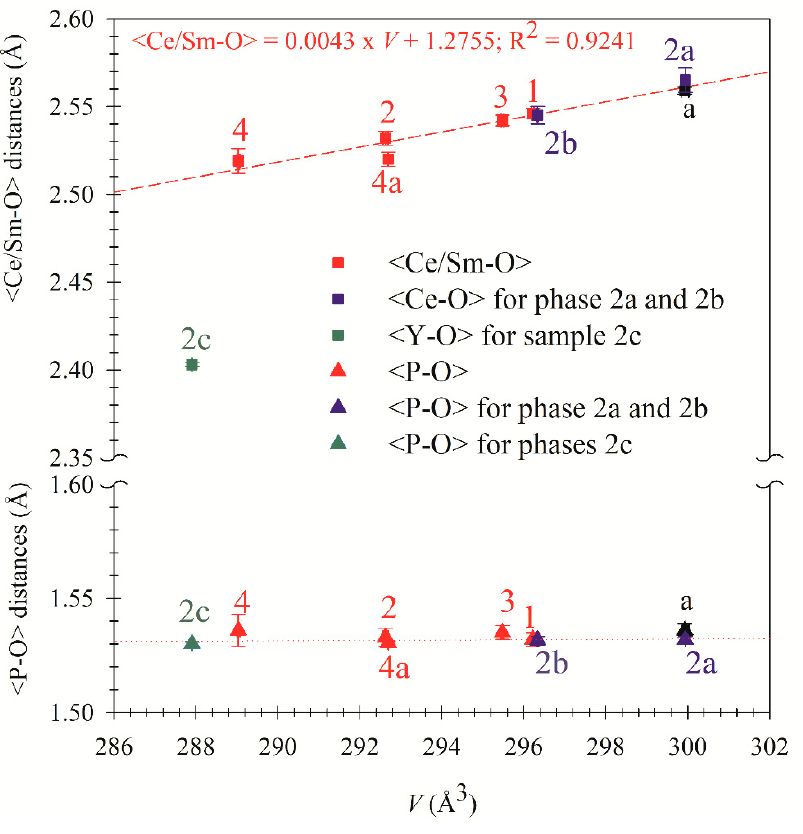
Figure 8. Variations of average <Ce/Sm-O>, <Y-O>, and <P-O> distances with V . The dashed line is a linear fit to the average <Ce/Sm-O> distances including that of sample “a” from Ni et al. [11] and the equation for this line is given (insert). The dotted line is for the average <P-O> distances. Sample 2 is based on SCXRD data [5], whereas 2a, 2b, and 2c are for the same sample 2 but these are based on HRPXRD data. Again, sample 4 is based on SCXRD data [5], whereas sample 4a is for the same sample 4 but based on HRPXRD data. Samples 1 and 3 were obtained with SCXRD [5].